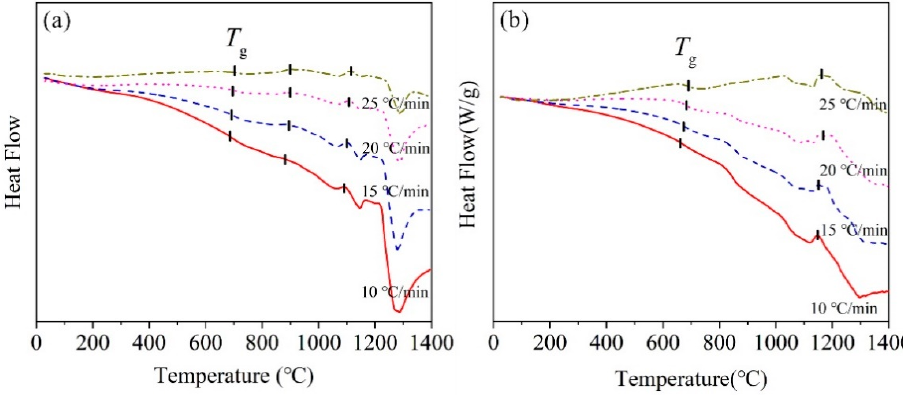
Figure 3. DSC curves of the ( a ) BG and ( b ) MBG measuredat different heating rates. Table 4. The obtained crystallization temperature ( T p ) of the BG and MBG.